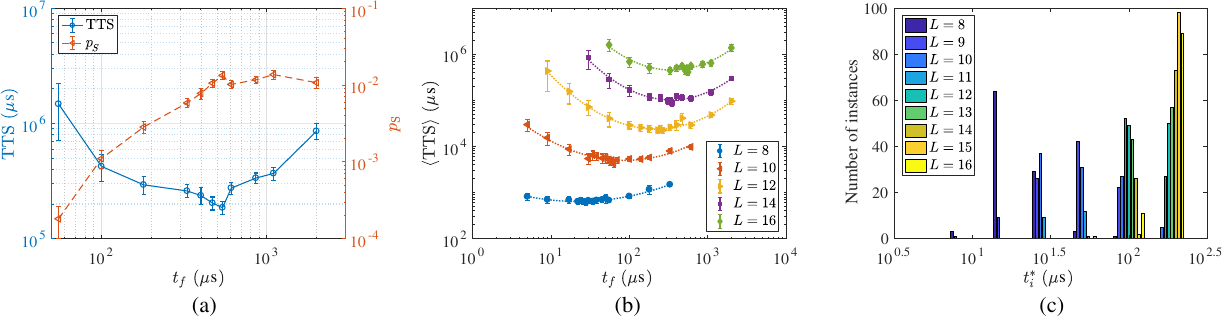
FIG. 15. Optimal annealing time and optimal TTS for the hardware-planted instance class on the DW2KQ. (a) TTS (blue solid line) and p (red dashed line) for a representative problem instance at size L ¼ 16 . A clear minimum in the TTS is visible at t (cid:3) ≈ 550 μ s, thus S demonstratingthe existenceofanoptimal annealingtime forthis instance.(b)MedianTTSasa functionofannealingtime for L ≥ 8 . Dotted curvesrepresentbest-fitquadraticcurves tothe data (seeAppendixK fordetails).Thepositionof h TTS i (cid:3) shiftstolarger t increases. An optimum could not be established for L < 8 for this instance class; i.e., it appears that t (cid:3) < 5 μ s when L < 8 . (c) The distribution of instance optimal annealing times for different system sizes, as inferred directly from the positions of the minima as shown in (a).Itisevidentthatthenumberofinstanceswithhigheroptimalannealingtimesincreasesalongwiththesystemsize,inagreementwith(b). In (a) and (b) error bars represent 95% confidence intervals ( 2 σ ) calculated using 1000 bootstraps of 100 gauge transformations [17].